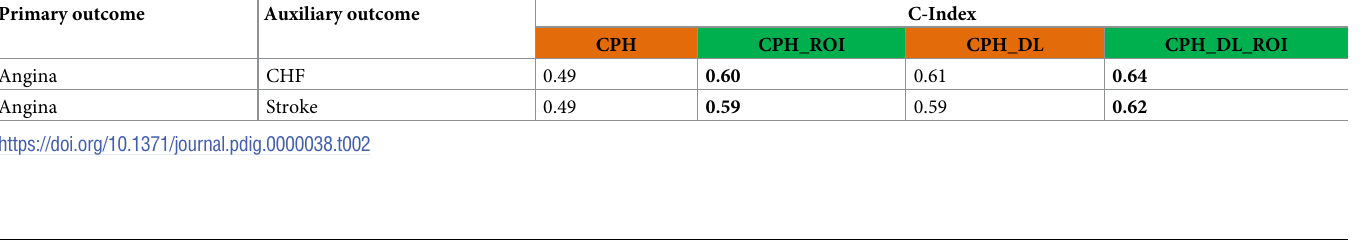
Table 2. TTE prediction model performance comparison on SHHS data. Primary